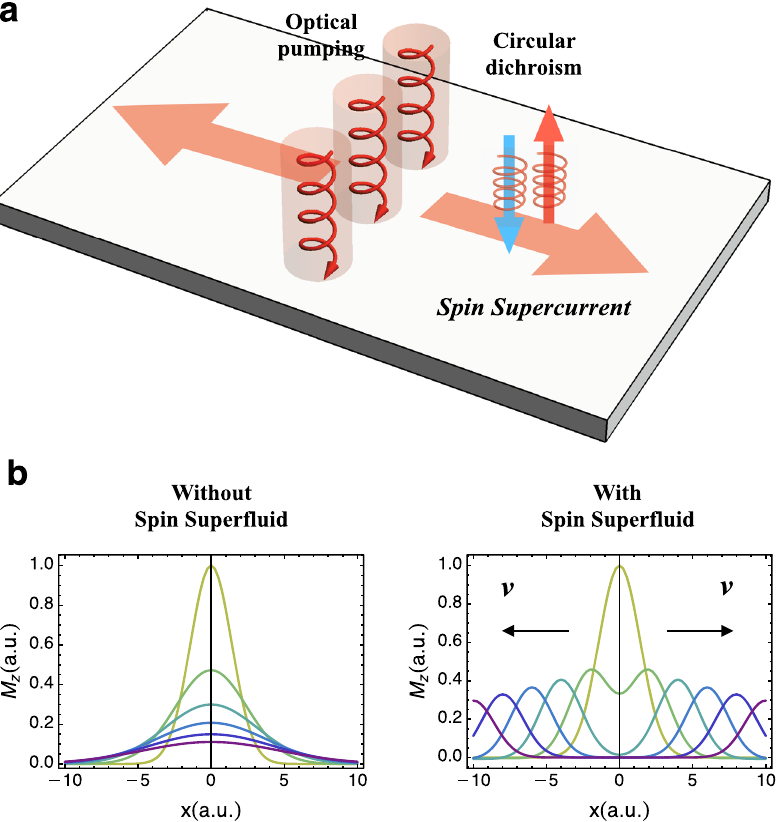
Fig. 3 Spin transport measurement. a Setup for all-optical spin transport measurement. ( b ) shows the dynamics of a spin-valley wavepacket in the case with/without spin super fl uid (colored curves represent different time instant). ( b ) is obtained by solving the Eqs. (9) and (10) in a 1 d system with an initial Gaussian distribution of M z at the origin. The parameters we use in the super fl uid case are v ¼